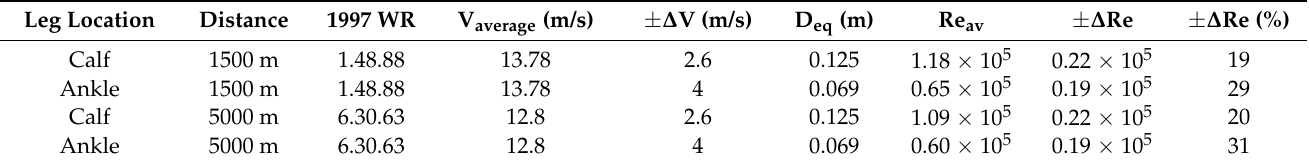
Table 2. Parameters to calculate the Reynolds number range of the lower